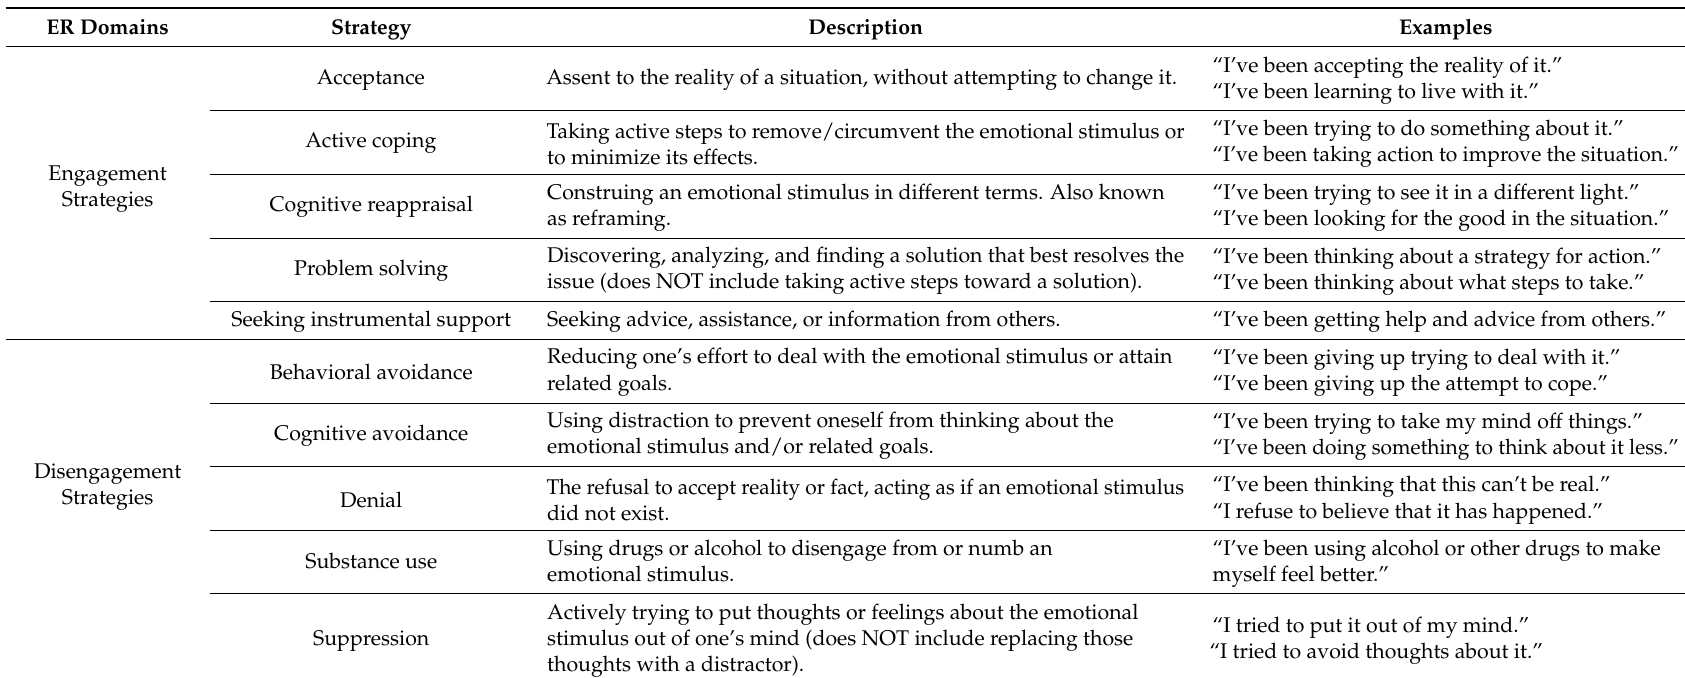
Table 1. Descriptions of commonly-used emotion regulation